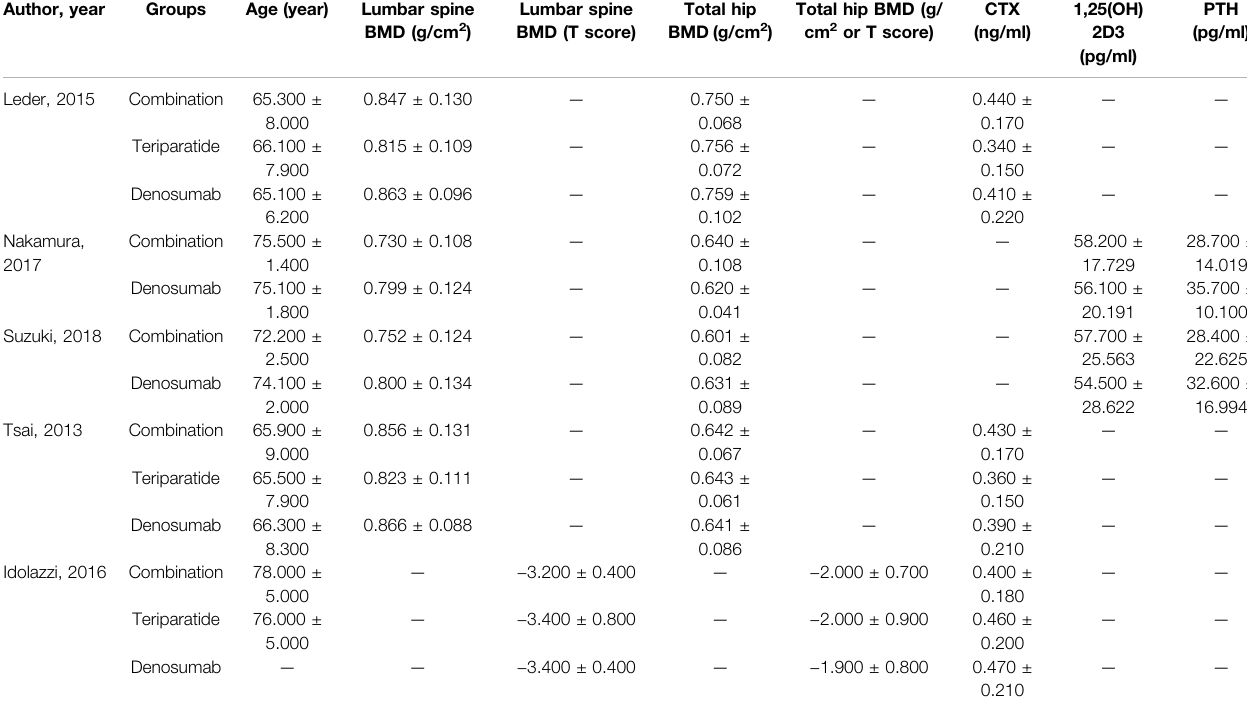
TABLE 2 | Baseline clinical characteristics of included study subjects.